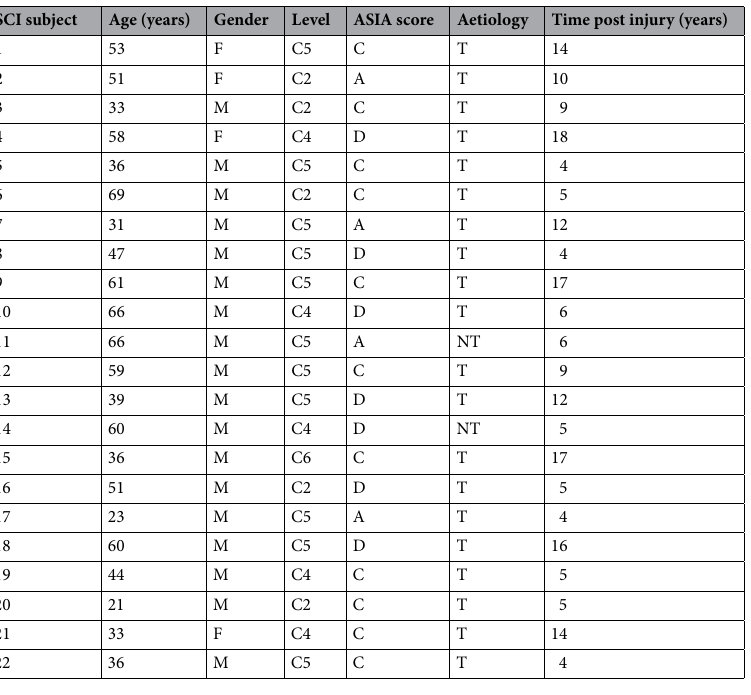
Table 1. Spinal cord injury participants. M male, F female, ASIA American Spinal Injury Association Impairment Scale, T traumatic, NT